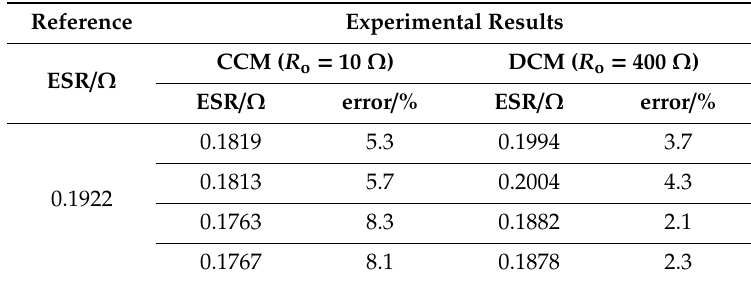
Table 5. ESR Experimental Results of Buck Converter by Method 2 after De-noising.